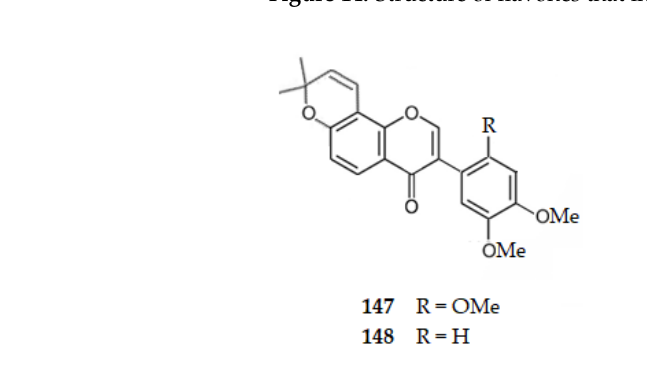
Figure 15. Structure of isoflavones 148 and 149 that inhibit AChE.